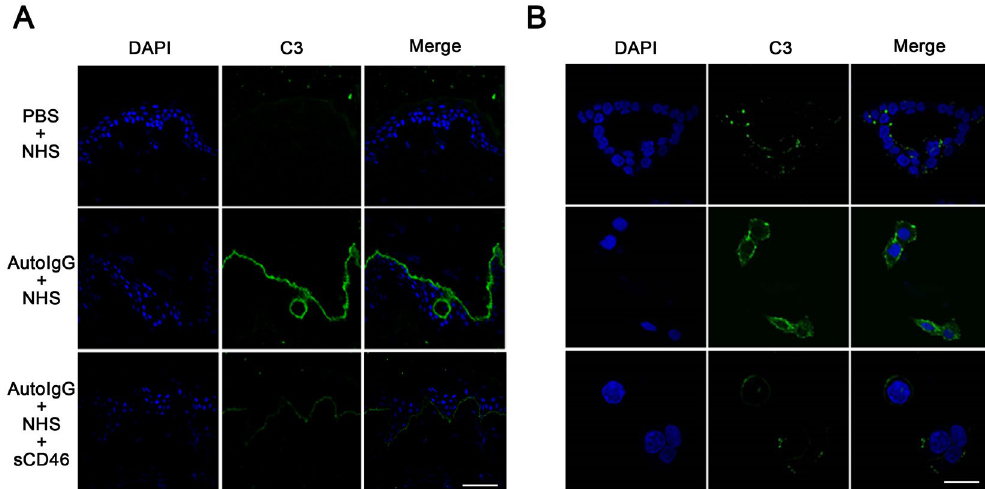
Figure 4. Recombinant CD46 inhibits autoantibody-mediated C3 deposition in BP pathogenesis. ( A ) Frozen skin sections from healthy controls and ( B ) HaCaT cells were incubated with purified auto-IgG and fresh serum from healthy controls containing complement components. C3 deposition was detected by IF staining to determine the complement activation level. Scale bars, 100 nm in (A) and 25 nm in (B) respectively. Auto-IgG, pathogenic IgG from BP patients’ serum; NHS, normal human serum; NC, negative control